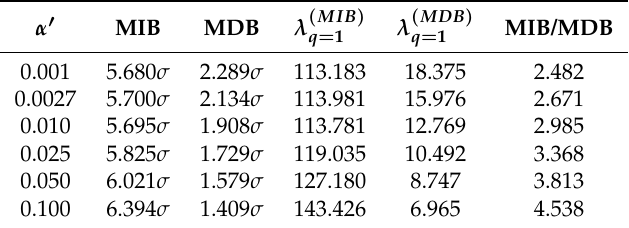
Table 11. Relationship between the MDB and MIB for ∆ h 6 and for ˜ P CD = ˜ P CI =